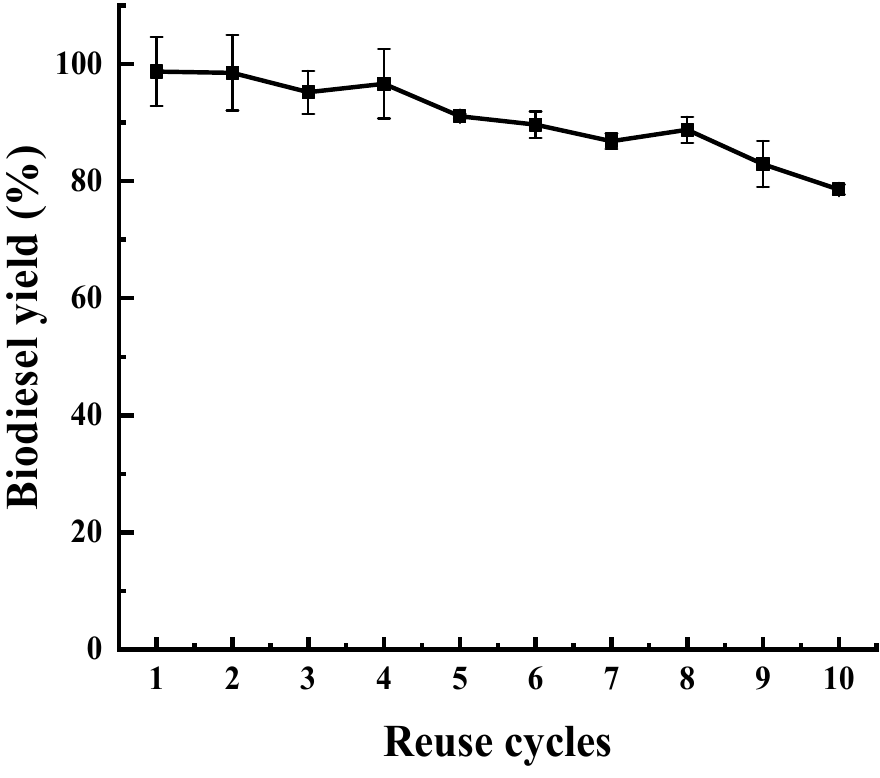
Figure 10. Effect of reuse of co-immobilized lipase on the yield of biodiesel (%). Reaction parameters were as follows: 4:1 molar ratio of methanol to oil (methanol was added 3 times at intervals of 40 min); 20% co-solvent; 10% water content; 8% lipase dosage; at 35 ± 1 °C; 120 min reaction time; under ultrasound-assisted parameters of 40% power and 40 kHz frequency (all % based on oil weight).